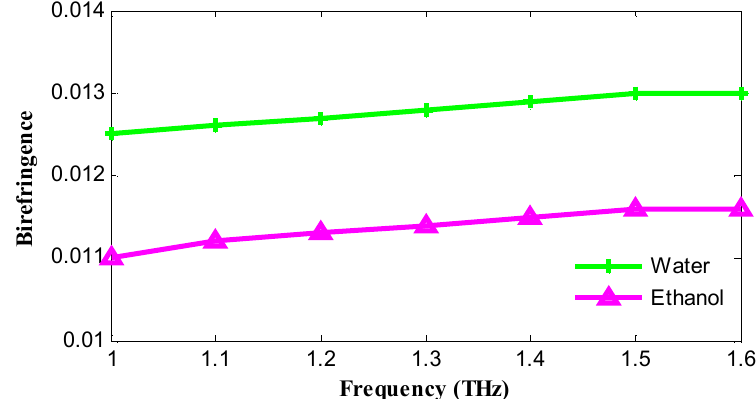
Figure 6. Birefringence of water-filled (green) and ethanol-filled (pink) core hole-based PCF as a function of frequency.